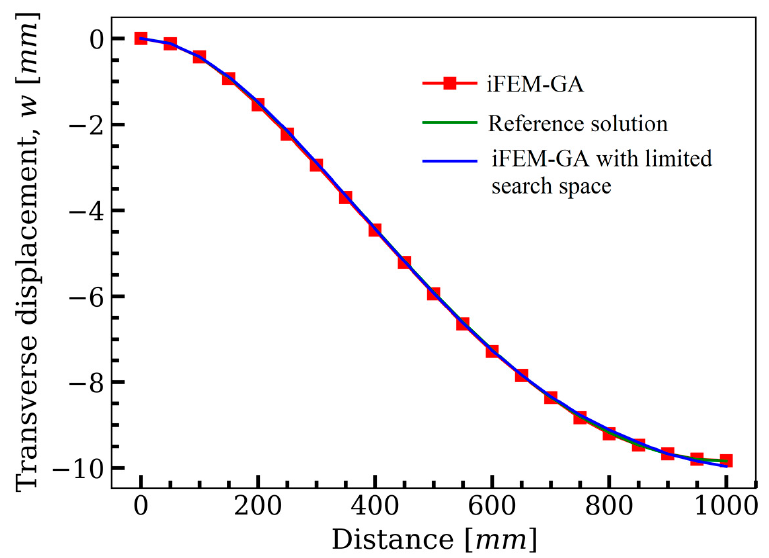
Figure 23. The comparison of the deflection of the plate in Figure 20 obtained with iFEM-GA analysis, iFEM-GA analysis with limited search space, and the reference solution through a defined path.